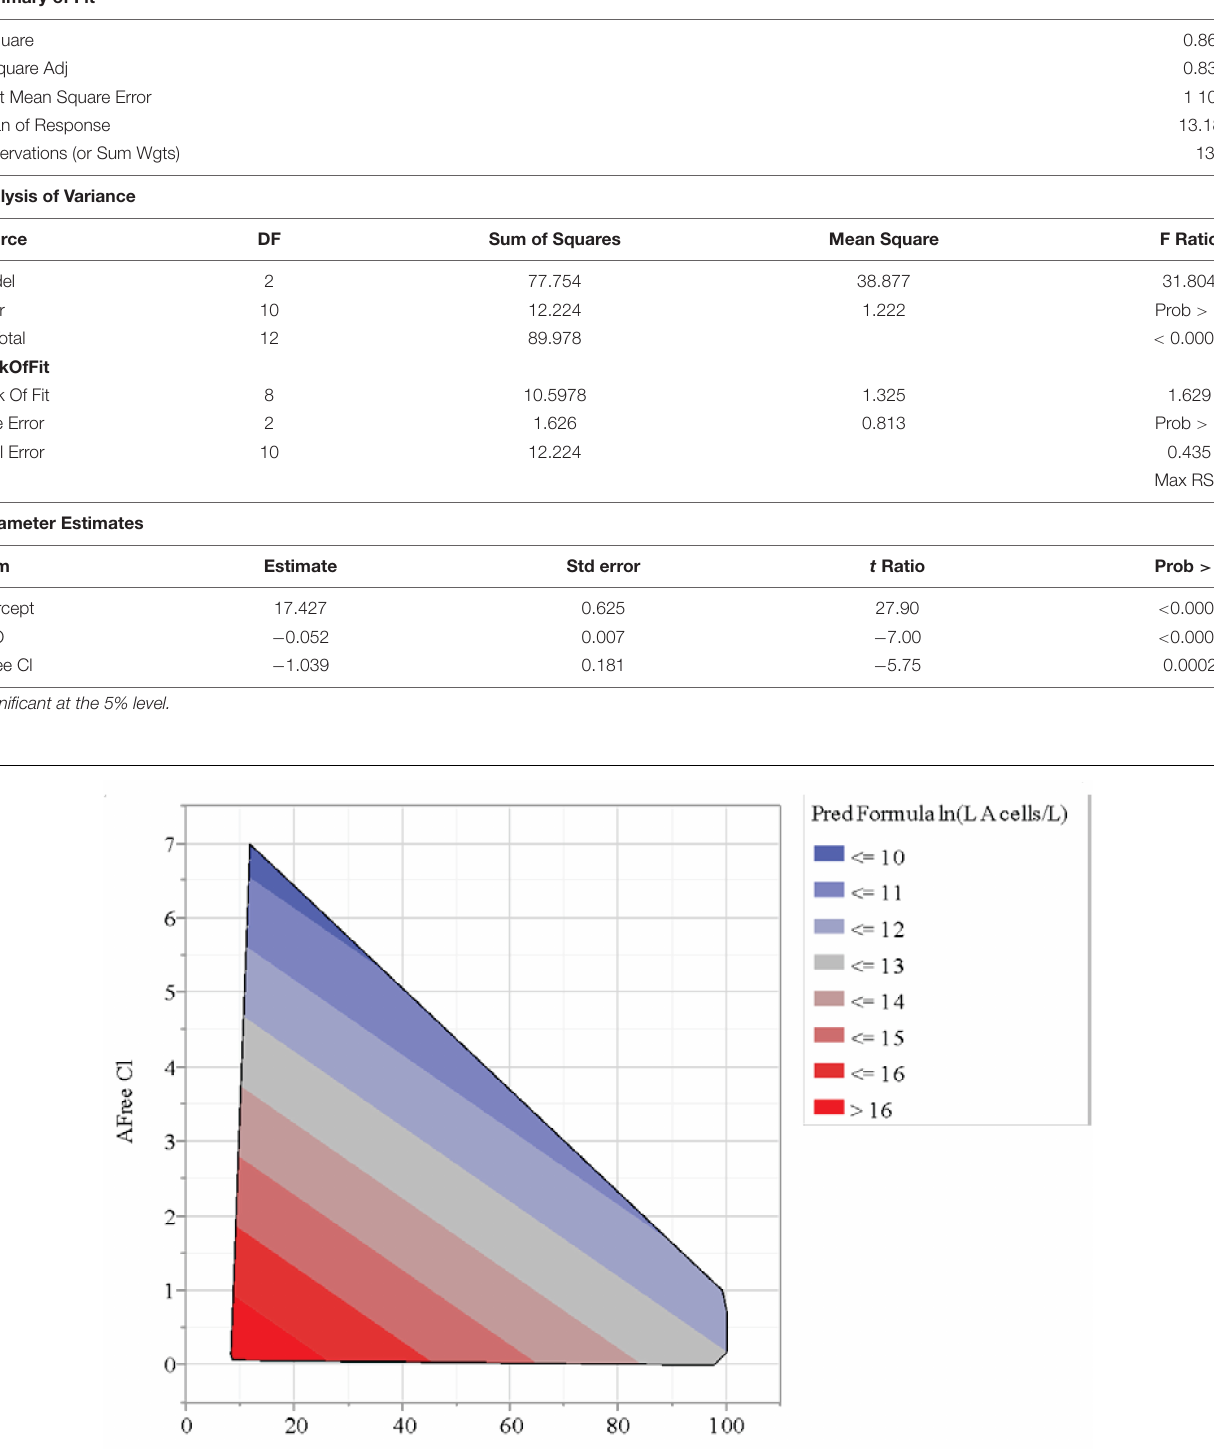
Frontiers in Microbiology |